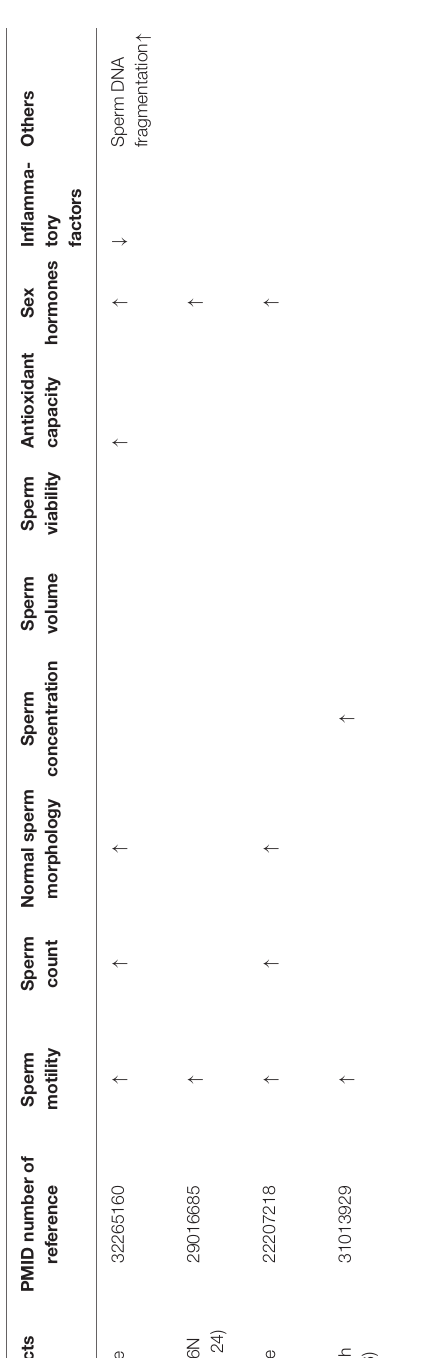
sperm/ejaculate to 79.04 ± 14.21 sperm/ejaculate, p = 0.001), sperm concentration (mean from 16.25 ± 4.5 × 10 6 /mL to 20.77 ± 6.49 × 10 6 /mL, p = 0.001), percentage of motile sperm (mean from 25.19 ± 6.46% to 33.21 ± 7.91%, p = 0.037), live sperm (mean from 52.37 ± 10.13 to 62.43 ± 12.17, p = 0.003), and serum and seminal total antioxidant capacity (mean